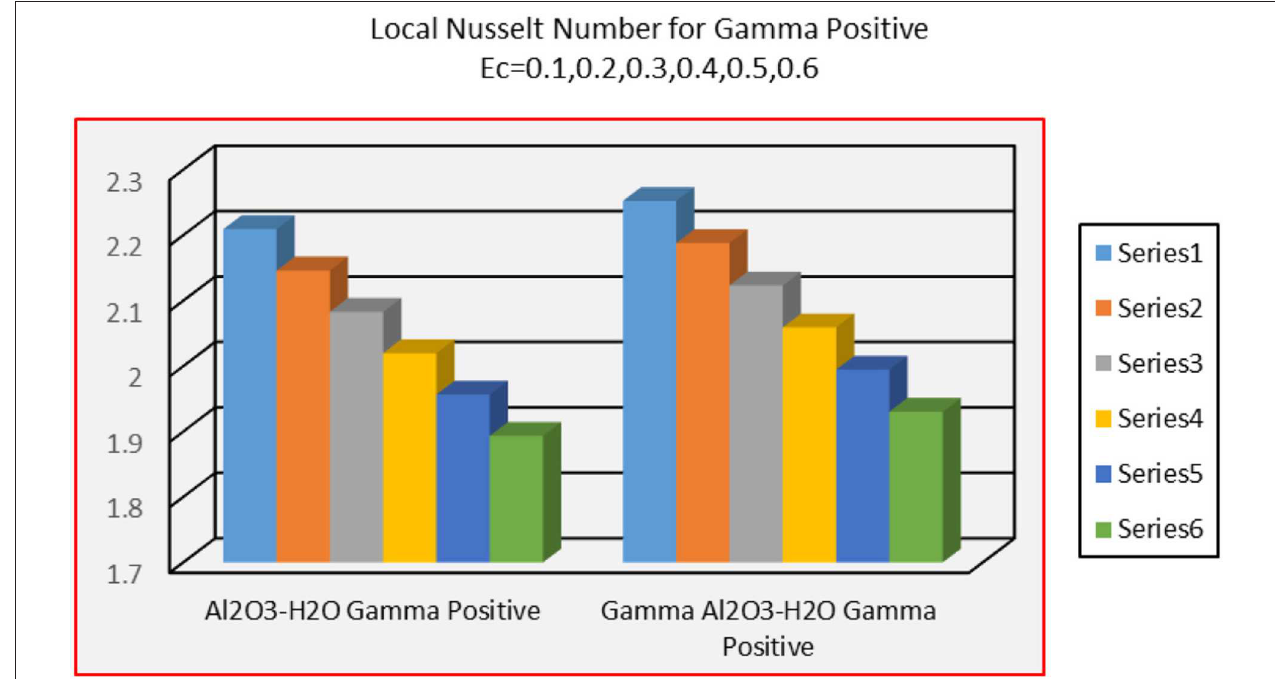
FIGURE 15 | The effects of Ec on local Nusselt number ( γ > 0).